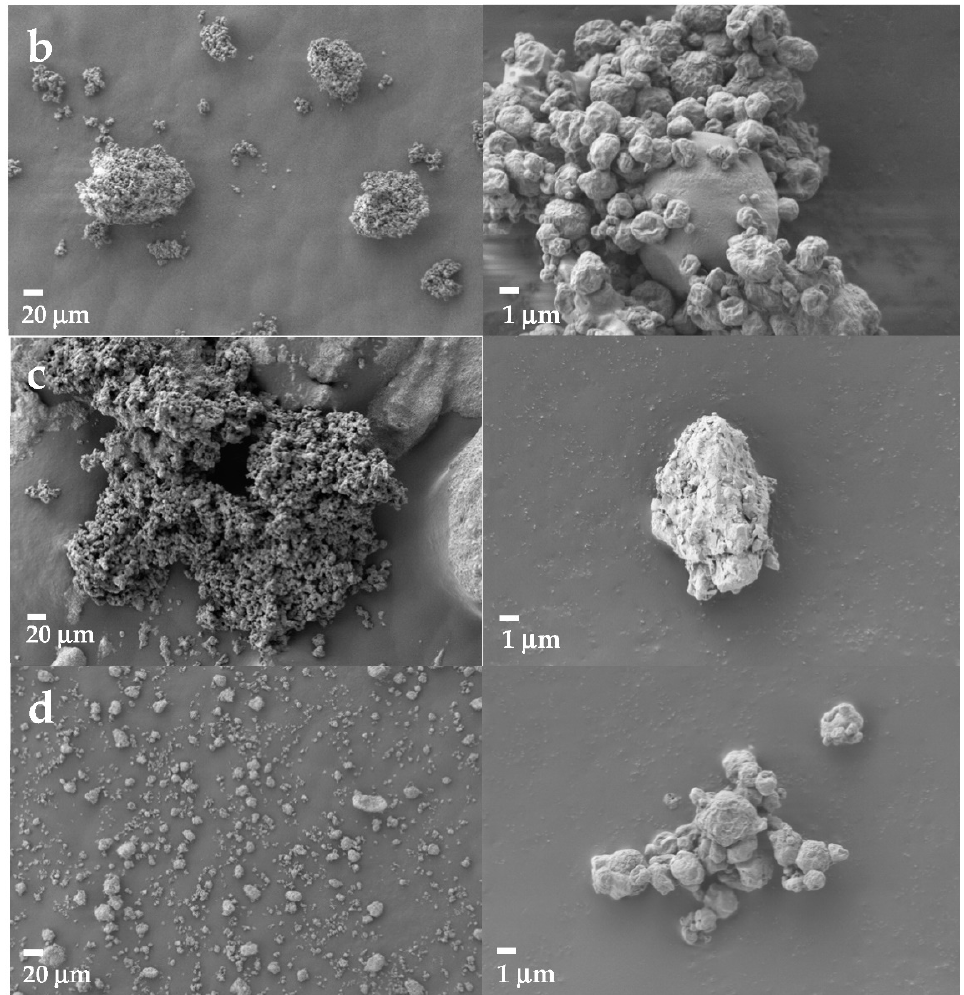
Figure 2. SEM images of ( a ) sucrose-based powders without rAAT; ( b ) sucrose-based powders with AAT; ( c ) mannitol-based powders without rAAT; ( d ) mannitol-based powders with rAAT. Left column, magnification 500×, scale bar 20 µm; right column, magnification 10,000×, scale bar 1 µm.